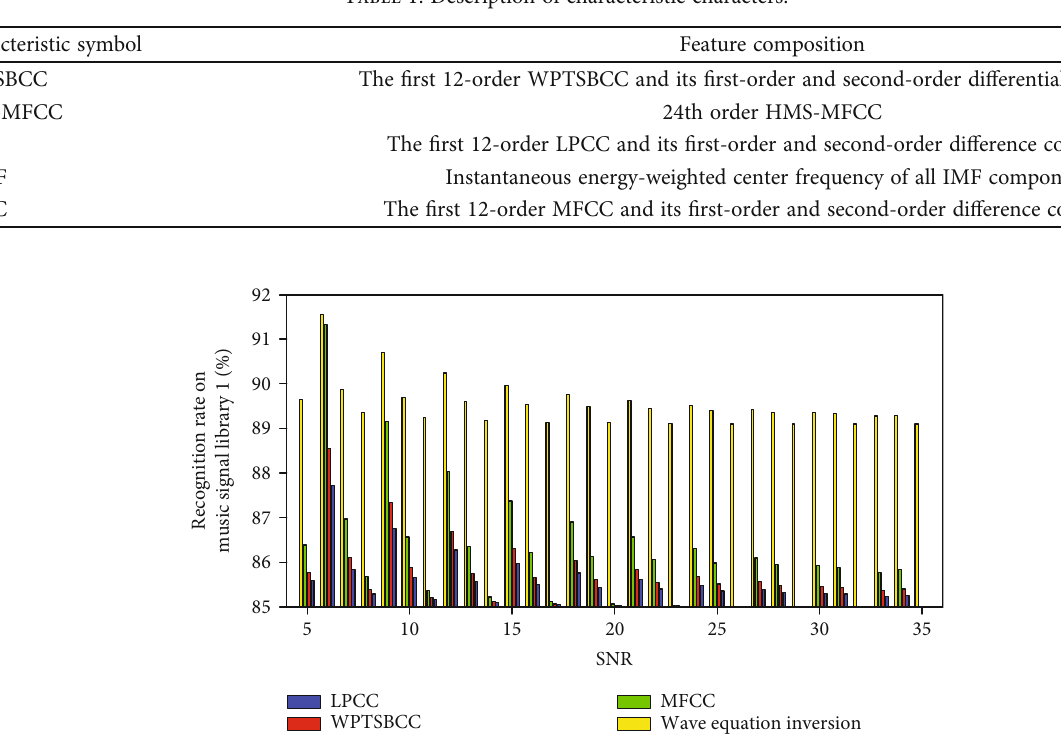
Figure 4: The recognition rate of di ff erent SNR on music signal library